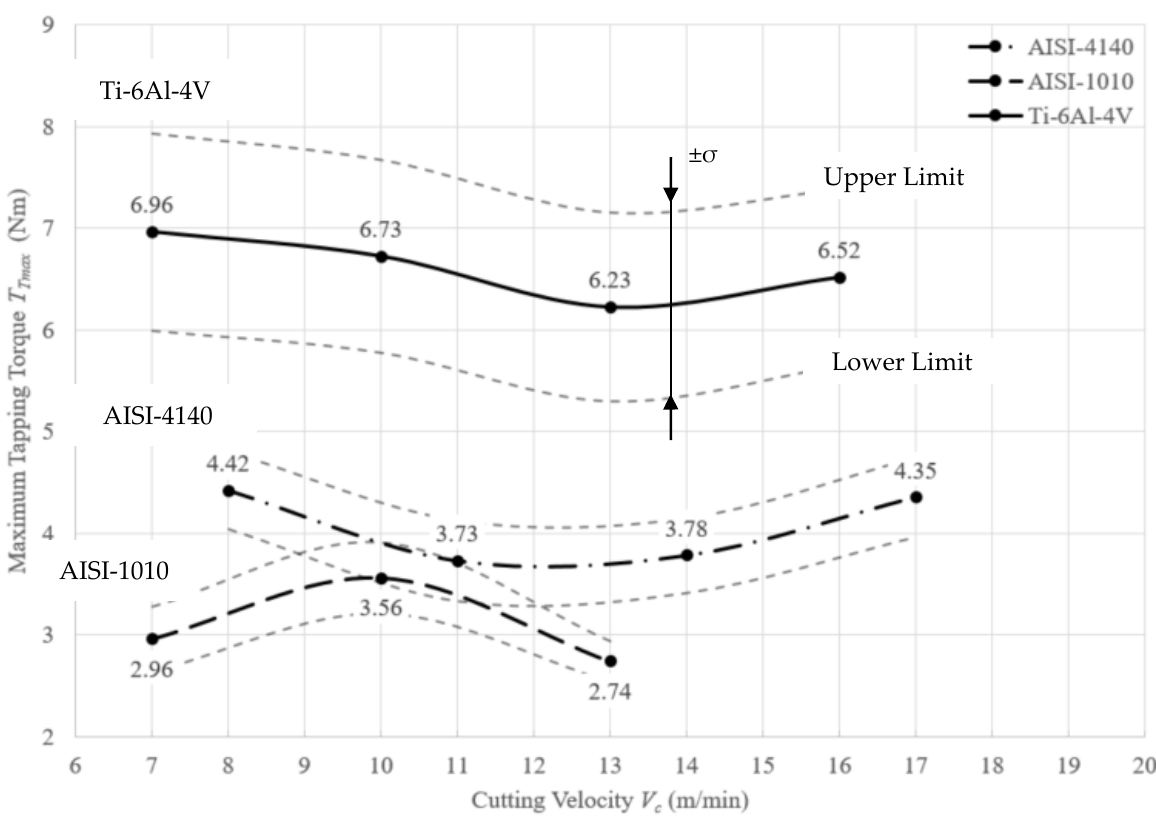
Figure 9. Maximum tapping torque for different materials and cutting speeds.